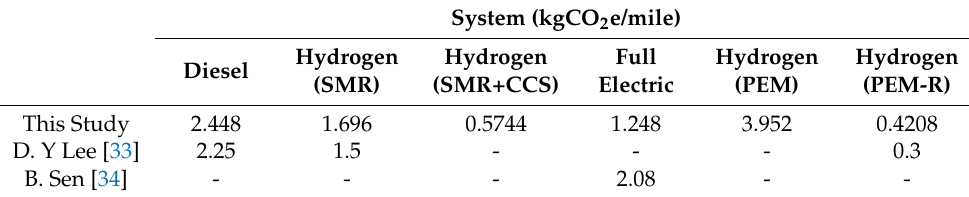
Table 11. System Life Cycle